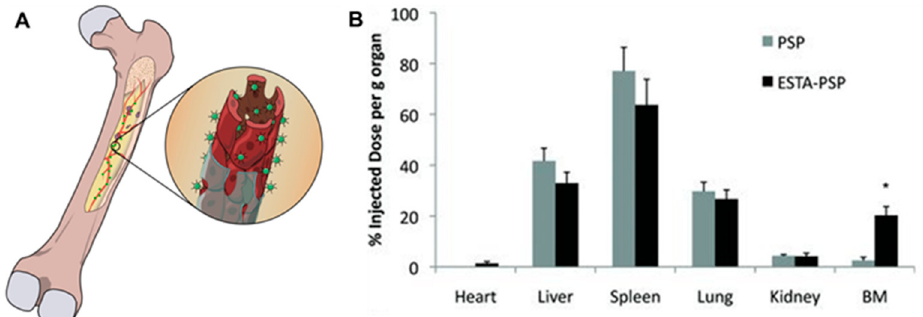
Figure 4. Drug delivery to the bone-marrow vasculature. ( A ) Scheme showing NP interaction with endothelial cells of bone-marrow capillaries. ( B ) Accumulation of E-selectin-targeted NPs (ESTA-PSP) to bone. Reprinted with permission from Reference [102].